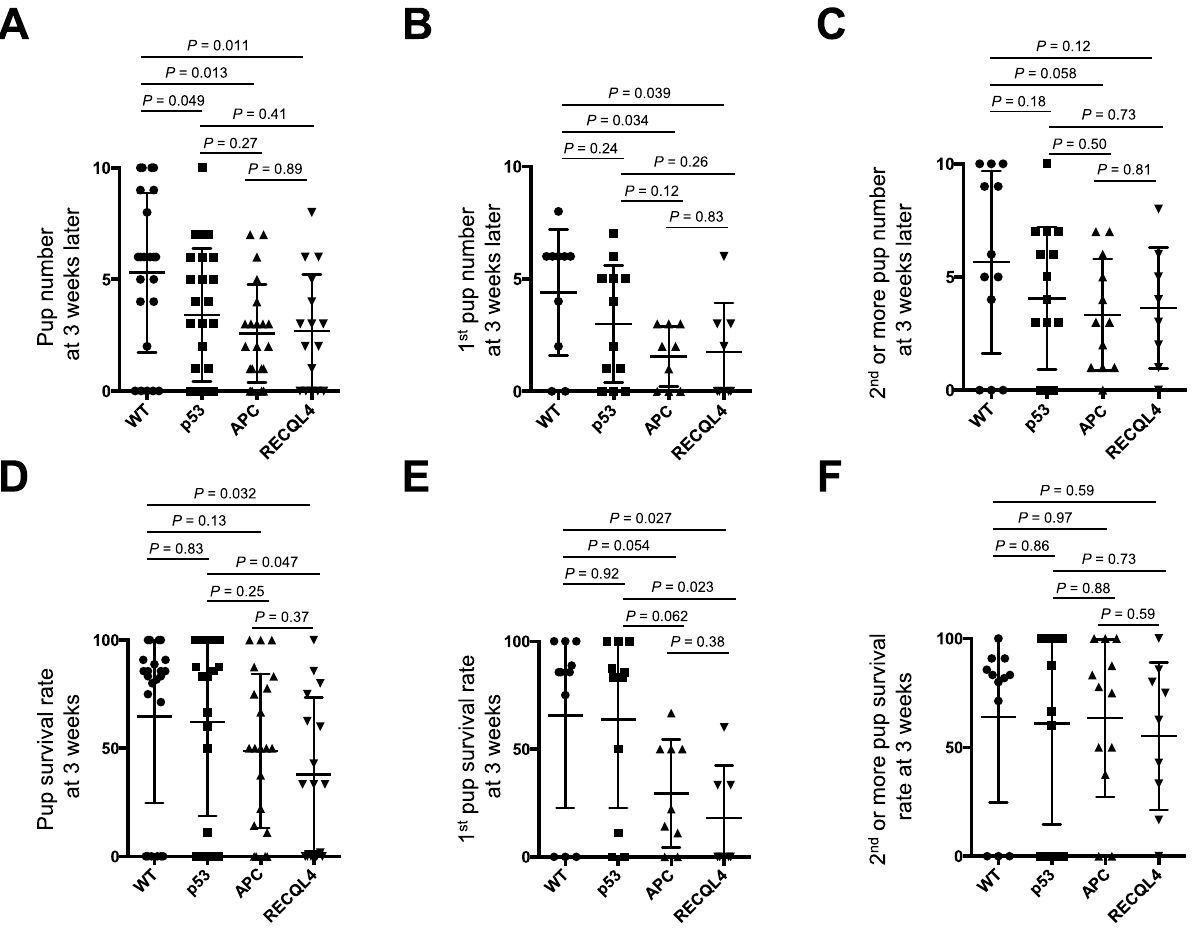
Figure 4. Pup numbers and survival rates at 3 weeks after birth. Pup numbers at 3 weeks after birth: total ( A ), in the 1st litter ( B ), and in the 2nd or later litter ( C ). The mean pup numbers are indicated by the bars. p values were determined by the Mann–Whitney U test or Welch’s t-test. Pup survival rates at 3 weeks after birth: total ( D ), in the 1st litter ( E ), and in the 2nd or later litter ( F ). The mean pup numbers are indicated by the bars. p values were determined by the Mann–Whitney U test or Welch’s t-test. p53: p53 −/− , APC: APC Min/+ , RECLQ4: RECQL4 HD/HD